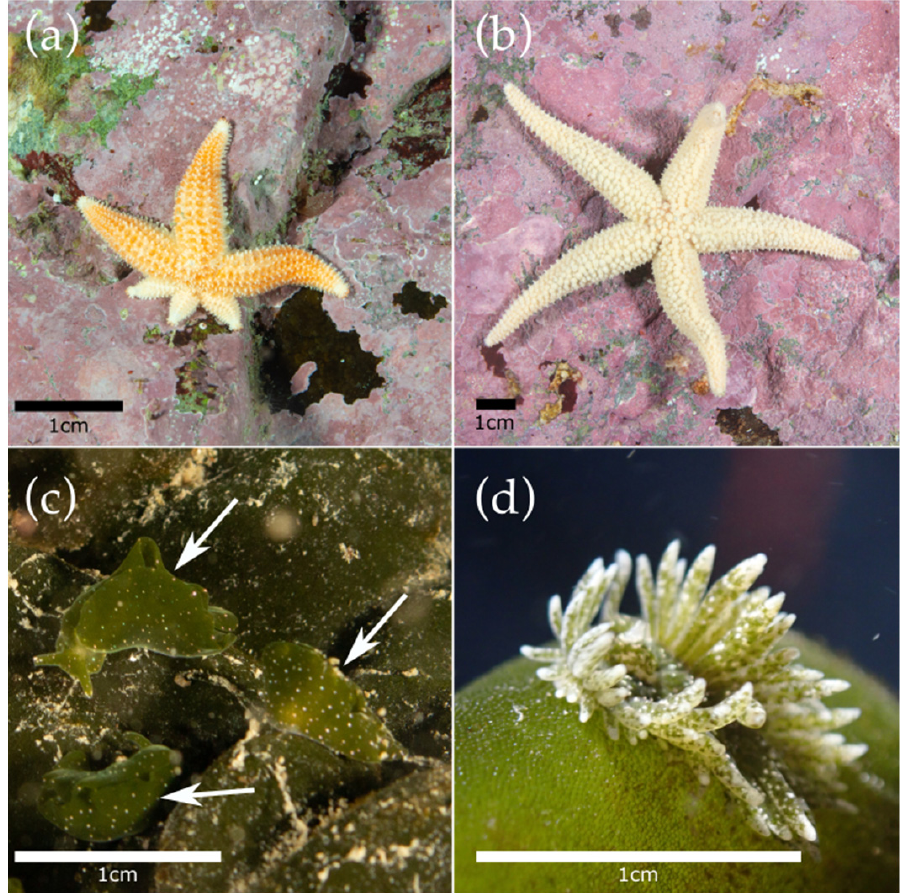
Figure 2. Field photos of those species that represented first photographic record for the area or southernmost record: ( a ) Allostichaster capensis (southernmost record); ( b ) Diplasterias brandti (first photo record for Beagle Channel); ( c ) Elysia patagonica (southernmost record), arrow indicates specimens; ( d ) Placida Sudamericana (southernmost record).